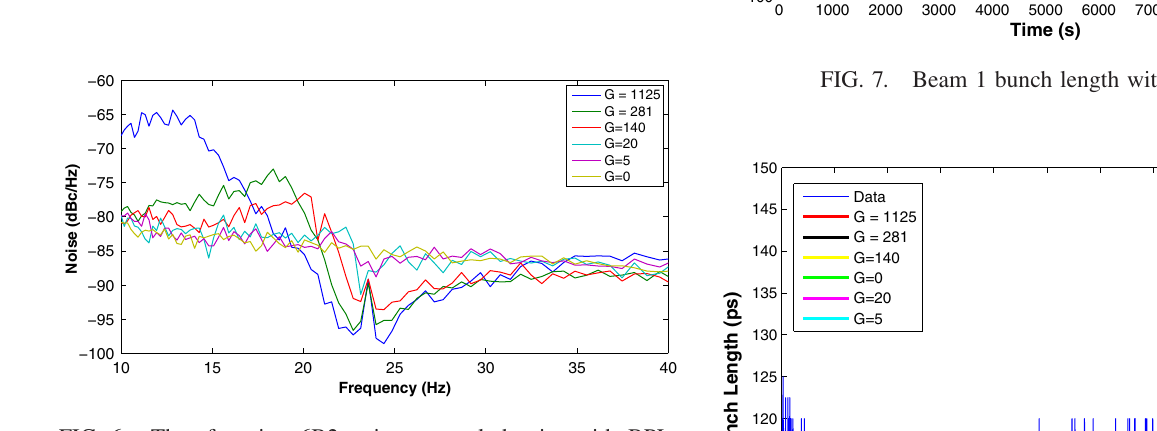
FIG. 6. The rf station 6B2 noise spectral density with BPL gain.